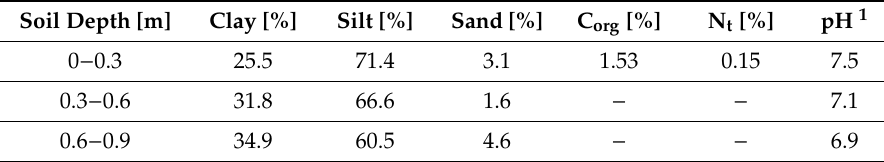
Table 1. Chemical and physical soil characteristics of the experimental field. Soil Depth [m] Clay [%] Silt [%] Sand [%] C org [%] N t [%] pH 1 0 −